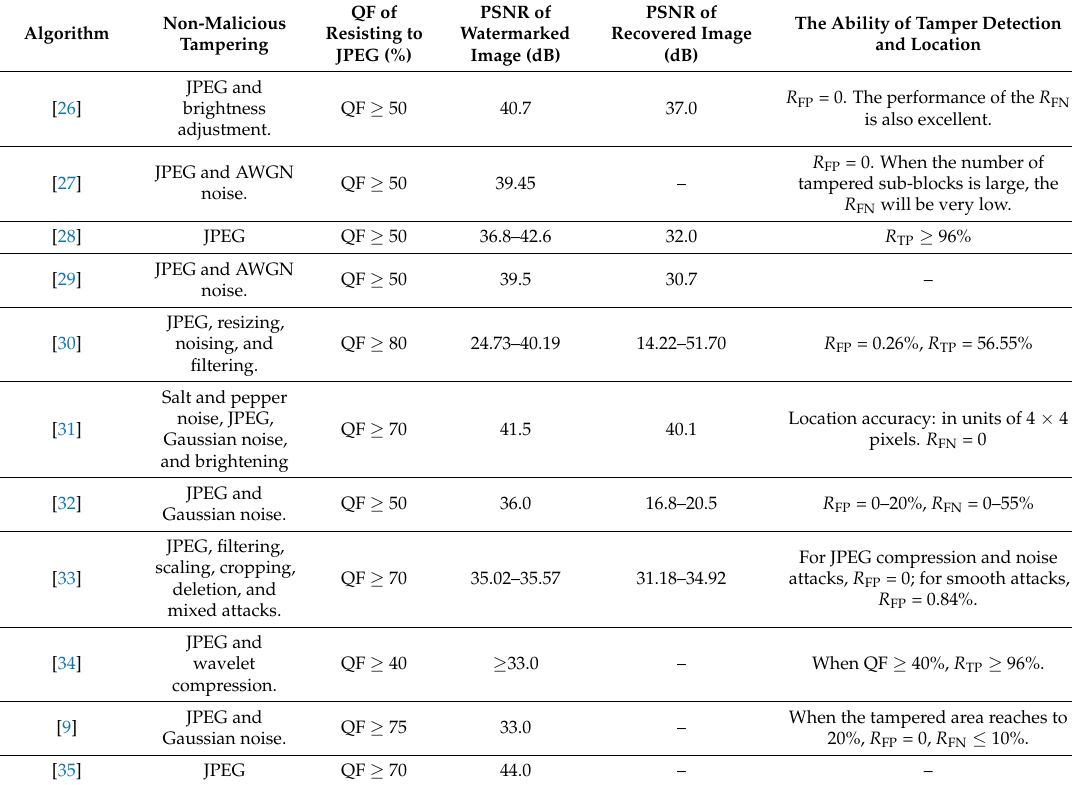
Table 4. Comparisons of the performance of various recoverable